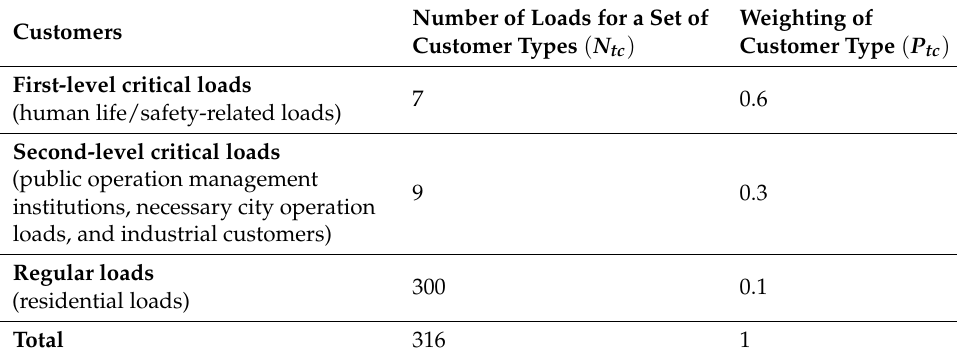
Table 1. Type of customers and their assigned weighting. Source: own